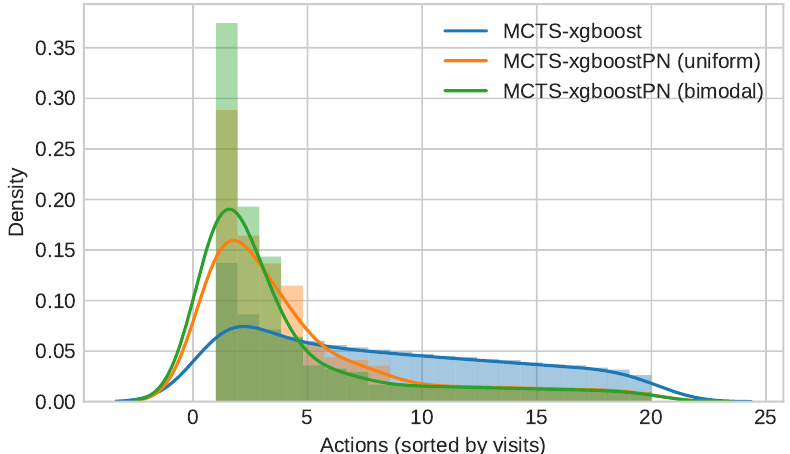
Figure 5. Actions’ visits distributions with and without pruning networks (1000